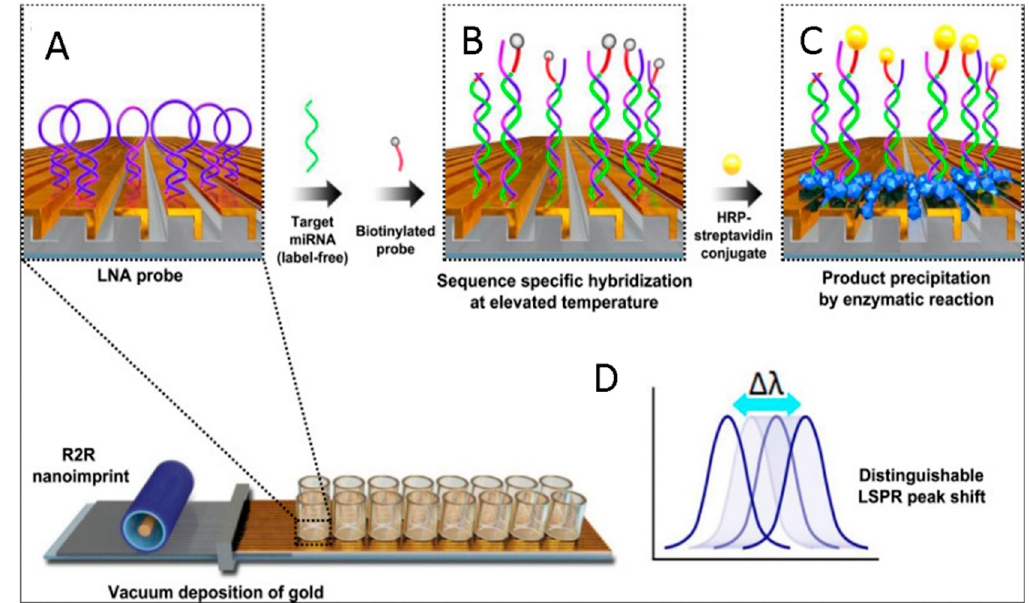
Figure 9. Schematic representation of a LSPR sensing platform based on flexible, transparent three-dimensional (3D) plasmonic nanostructure for the detection of miRNAs. A LNA hairpin probe is immobilized on the plasmonic structure ( A ). The hybridization with the specific miRNA cause the opening of the hairpin ( B ) and the subsequent binding of a second labelled probe for signal amplification ( C ). The presence of the specific miRNA can be detected by a shift of plasmonic peak ( D ). Reproduced with permission from [89].